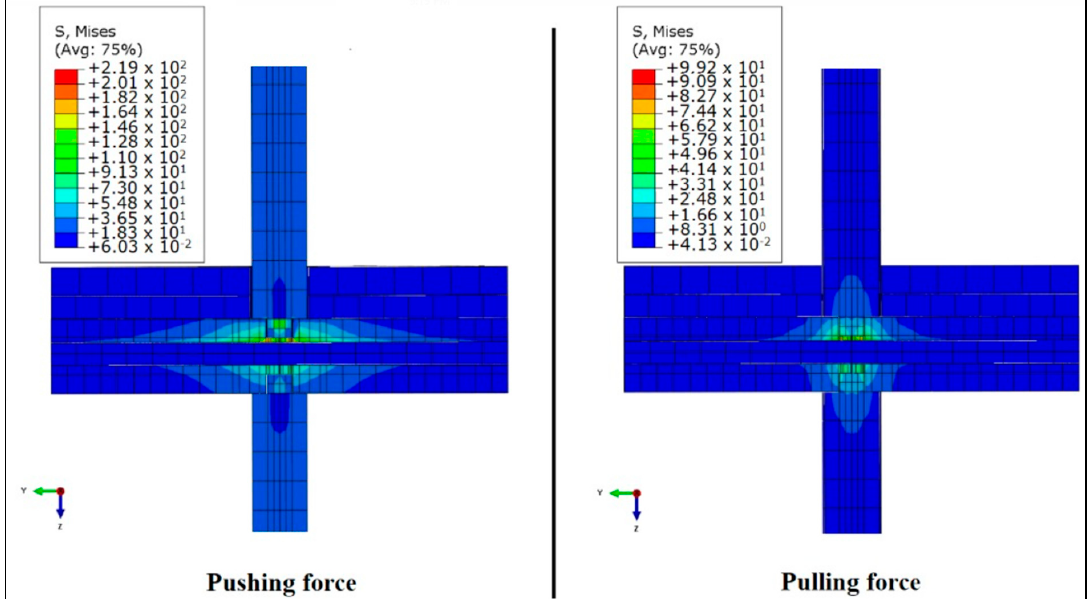
Figure 13. Meshing and stress contour of the FE model.